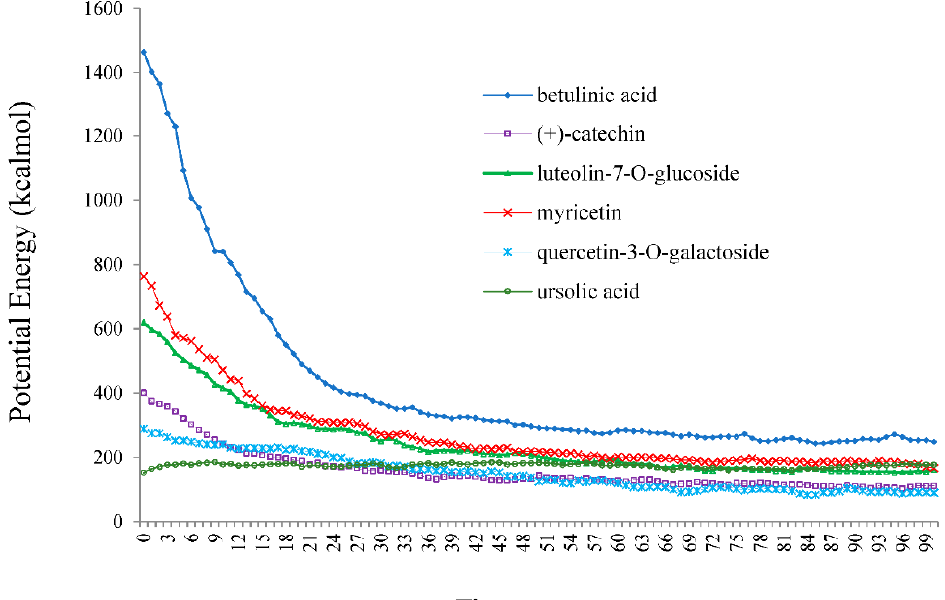
Figure 8. Potential energy (kcal/mol) versus time for betulinic acid, (+)-catechin, luteolin-7-O-glucoside, myricetin, quercetin-3-O-galactoside, and ursolic acid in water at 300 K extracted from Monte Carle simulation method.